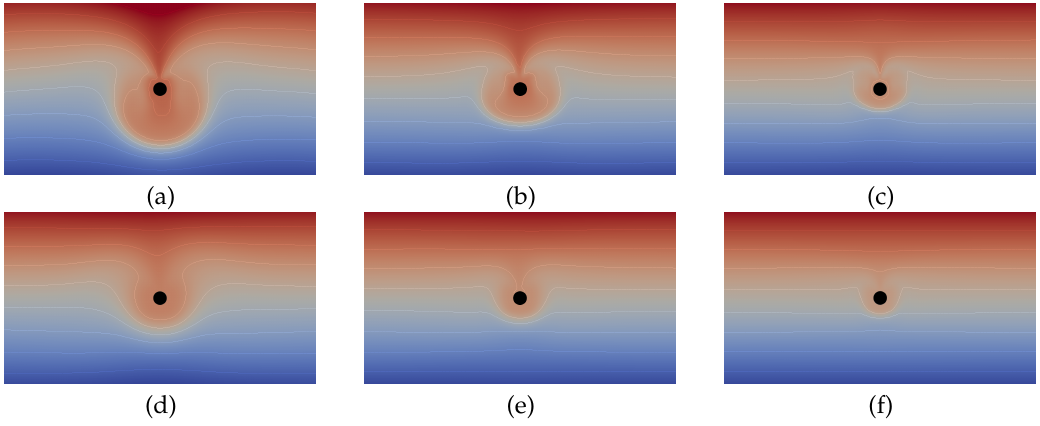
Figure 5. Concentration distribution from simulations of a paraffin oil drop placed in an aqueous solution with a vertical gradient of surface active solute. The value of the volume expansion coefficient is varied relative to that of isopropyl alcohol as: 0.1 ( a , d ); 1 ( b , e ); and 10 ( c , f ). Shown is a section of 5.5 mm × 3 mm of the computational domain. The upper row ( a – c ) displays the active stage of Marangoni convection, corresponding to a local maximum in the curves of Figure 6b, while the lower row ( d – f ) shows the final part of the relaxation stage, corresponding to a local minimum in the curves of Figure